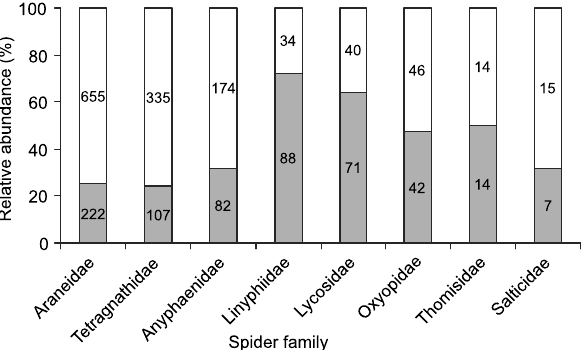
Figure 5. Effect of insecticide treatment on spider family abun- dances (adults and juveniles) in ricefields at Capivari do Sul, Eldorado do Sul and Cachoeira do Sul, Rio Grande do Sul, Brazil. Families in decreasing order of abundance, numbers inside col- umns represent absolute values. Only families with more than 20 individuals shown. ( (cid:133) ) Control, ( (cid:132) ) insecticide.